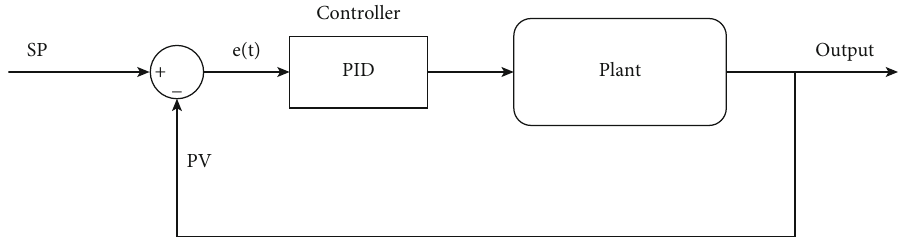
Figure 2: PID controller features.